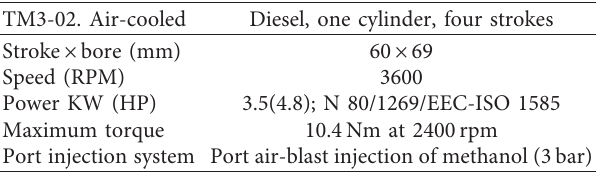
Table 1: Engine specifications with experiment